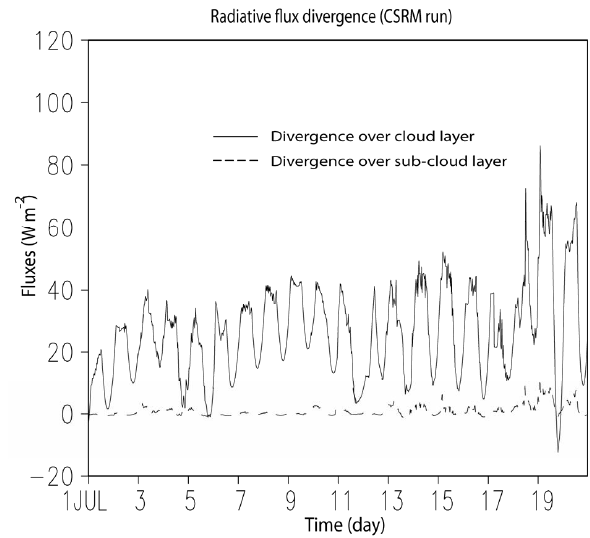
Fig. 13. Time series of averaged (over the horizontal domain) net radiative flux divergence (Wm − 2 ) over the cloud layer (solid line) and over the sub-cloud layer (dashed line) for the CSRM run. When clouds are not present, the cloud layer is defined as the layer be- tween the LCL and the MBL Figure 12 1438 Fig. 12. Time series of averaged (a) 1q tBL (gkg − 1 ) and (b) 1θ tBL (K) over the horizontal domain for the CSRM run.